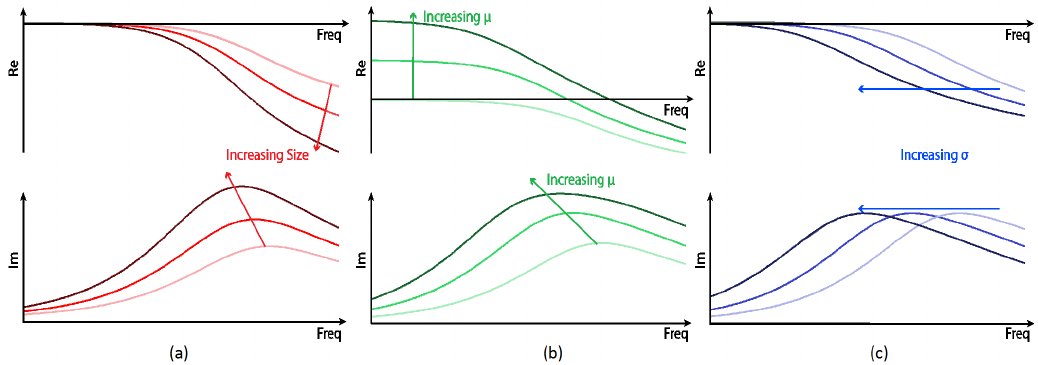
Figure 2. Typical complex spectral responses for: ( a ) increasing object size; ( b ) increasing object